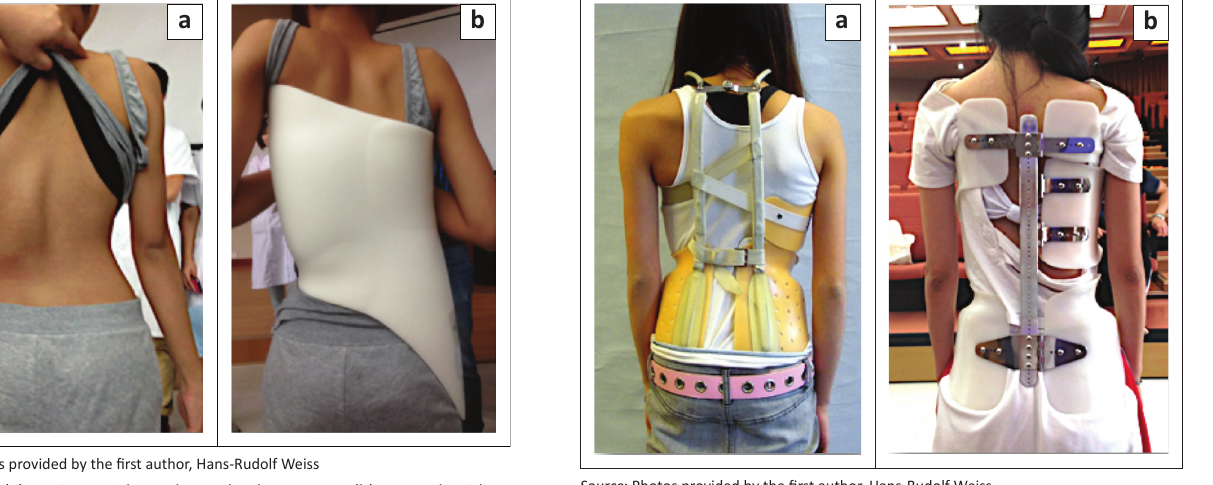
FIGURE 6: (a) Scoliosis patient in a Milwaukee brace and (b) another in a Lyon brace according to Stagnara. Both braces were made for a right thoracic